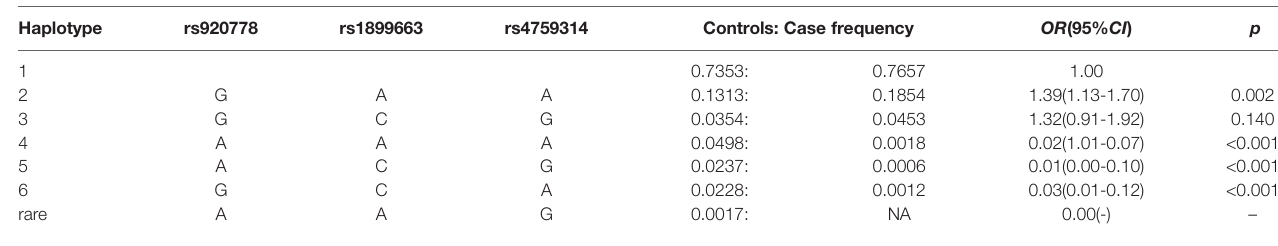
TABLE 5 | Haplotype distribution